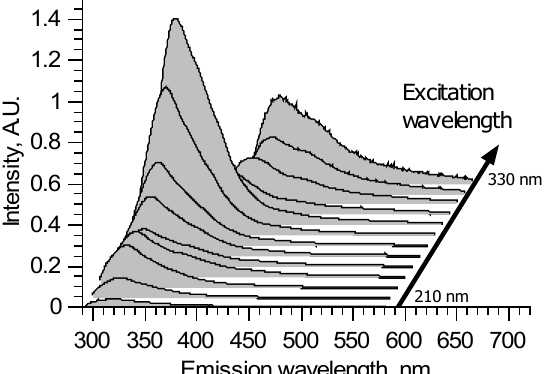
Figure 1. An example of laser-induced fluorescence excitation–emission matrix for artery sample.